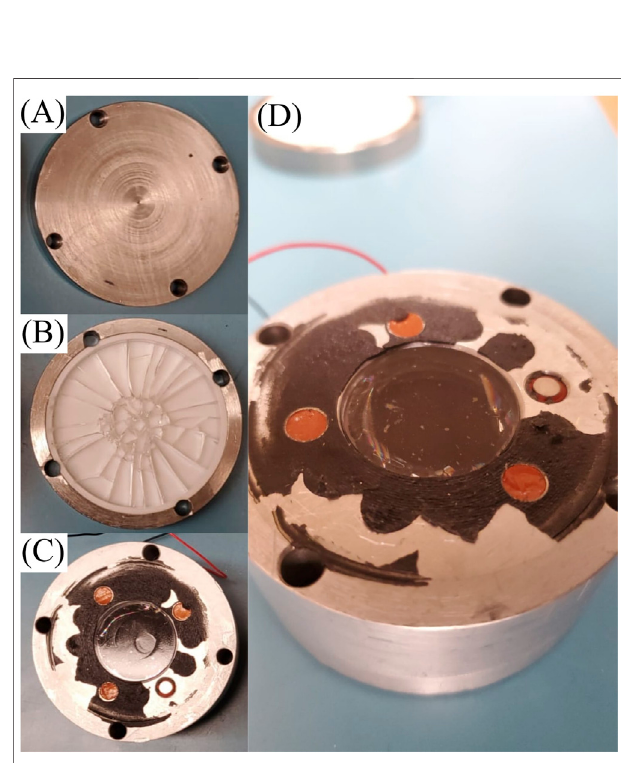
FIGURE5| DisassembledTestarticle#2afterimpact. (A) Baseplate. (B) Canister ring and PTFE cup housing the glass disk. (C) Potted canister core, three mock actuators, and one COTS piezo actuator in their slots. (D) Enlarged image.